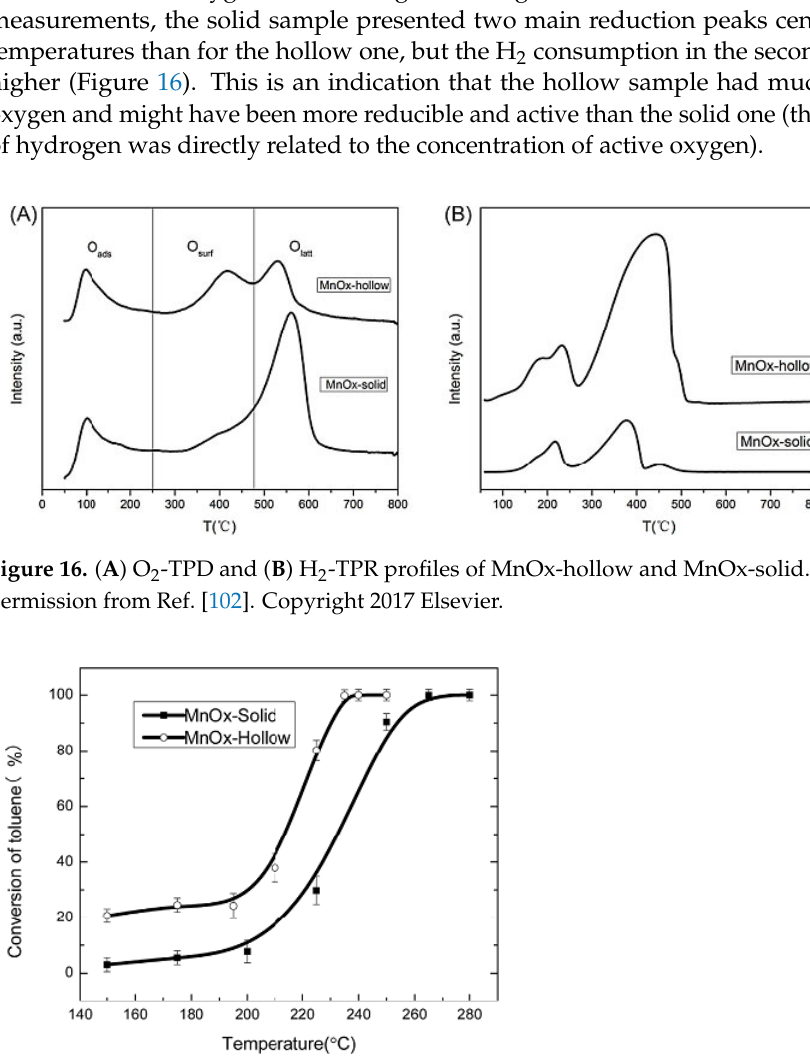
mL/(gh). Reprinted with permission from Ref. [101]. Copyright 2012 American Chemical Society.